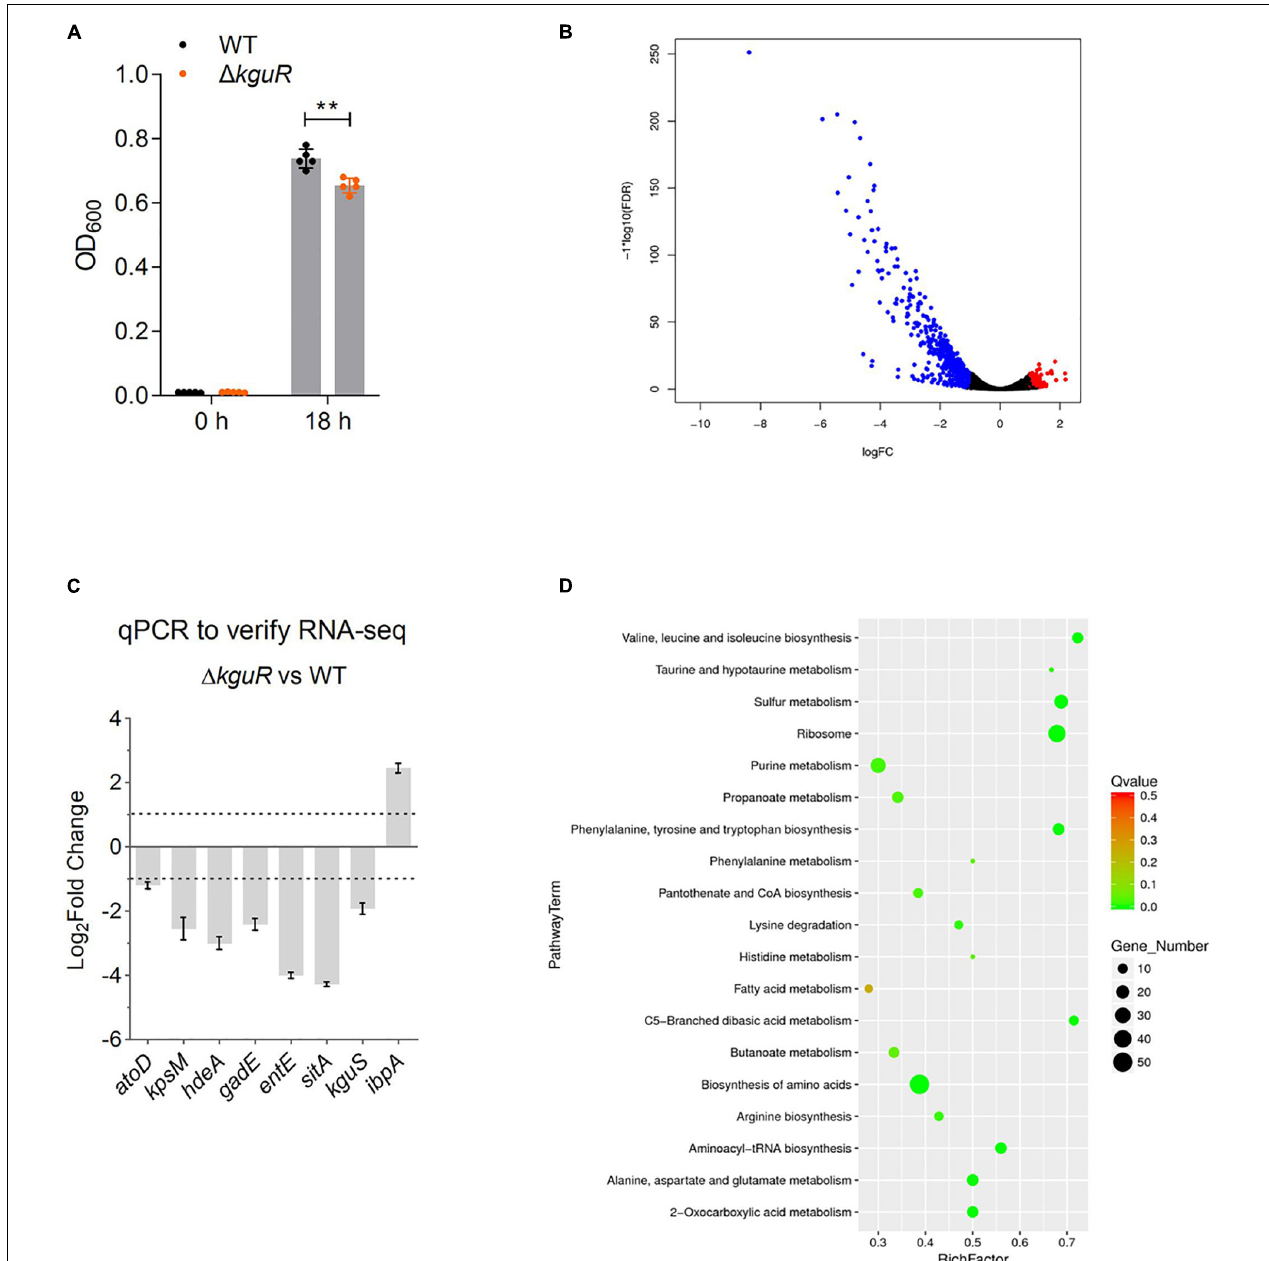
FIGURE 1 | RNA-seq analysis reveals extensive transcriptomic changes due to kguR deletion. (A) Growth of wild-type CFT073 and the (cid:49) kguR mutant. The data represent the mean ± SD of five replicates, and experiments were repeated independently for three times. (B) Volcano plot showing transcriptomic changes due to kguR deletion. (C) qPCR validation of select differentially expressed genes. atoD codes for acetate CoA-transferase subunit alpha; kpsM for polysialic acid transport protein; hdeA for acid stress chaperone; gadE for acid resistance transcriptional regulator; entE for enterobactin synthase component E; sitA for iron/manganese ABC transporter substrate-binding protein; kguS for HK of the TCS KguS/KguR; ibpA for small heat shock protein. (D) A bubble chart demonstrates KEGG pathway enrichment of DEGs. The y -axis label represents each pathway, and the x -axis indicates the enrichment factor, which was calculated as the ratio of the number of DEGs enriched in the pathway to the number of all genes in the background gene set. The size and color of each bubble represent the number of DEGs enriched in the pathway and the statistical significance of the enrichment, respectively. ** P < 0 . 01 by Student’s t -test.